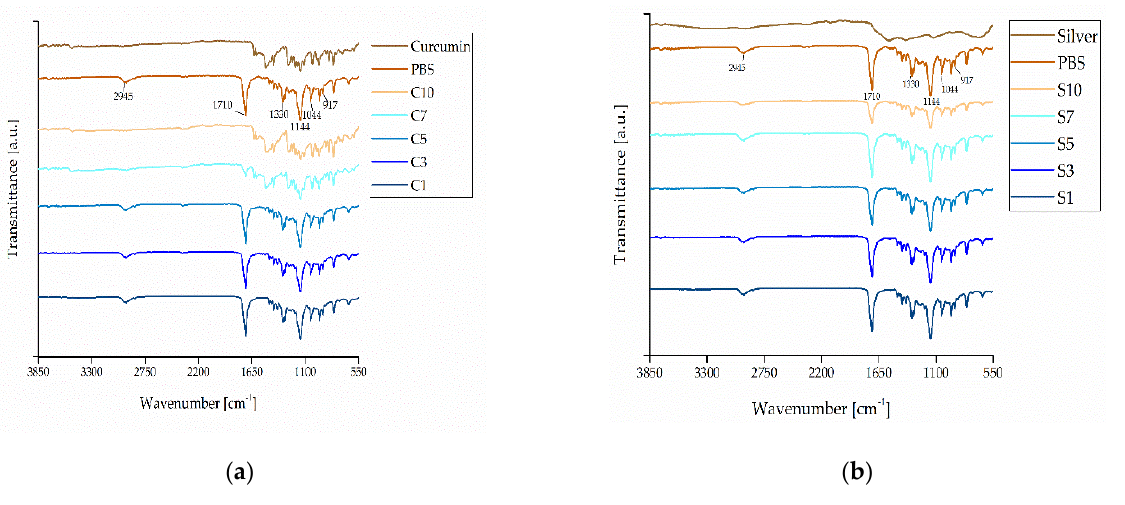
Figure 15. FTIR spectra of PBS, the additives, and the resulting compounds. ( a ) PBS, curcumin and PBS-curcumin compounds. ( b ) PBS, silver and PBS-silver compounds.